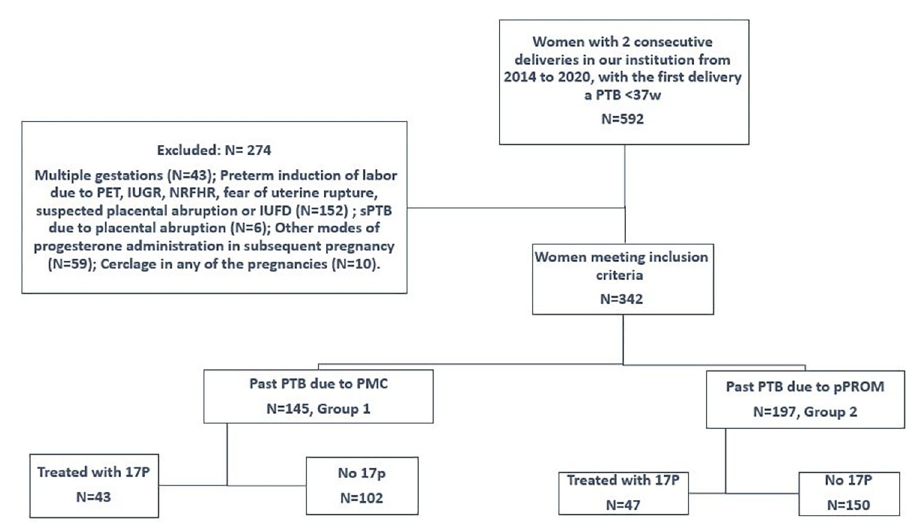
Fig 1. Flowchart describing the study population. Each group based on the presenting symptom–PMC or pPROM– was evaluated within itself comparing the treated vs. the untreated populations. Each woman was also analyzed individually according to the difference in GA between